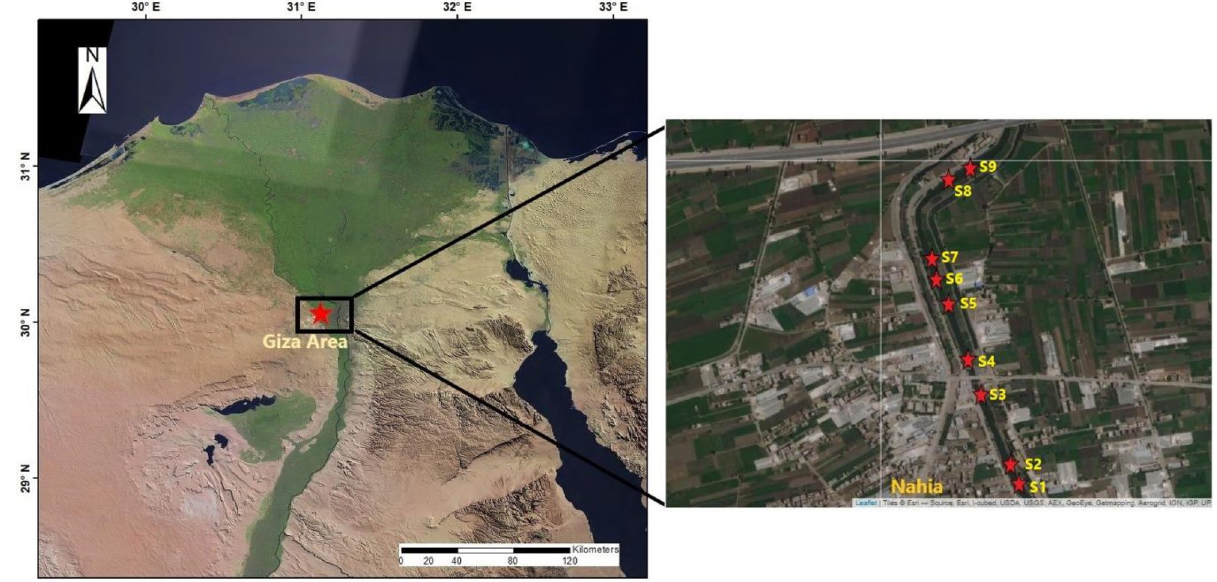
Figure 1. Study area showing Al-Labene Drain (red star) in Nahia, Giza Area. Sampling site ( S1 – S9 ) locations are indicated with small red